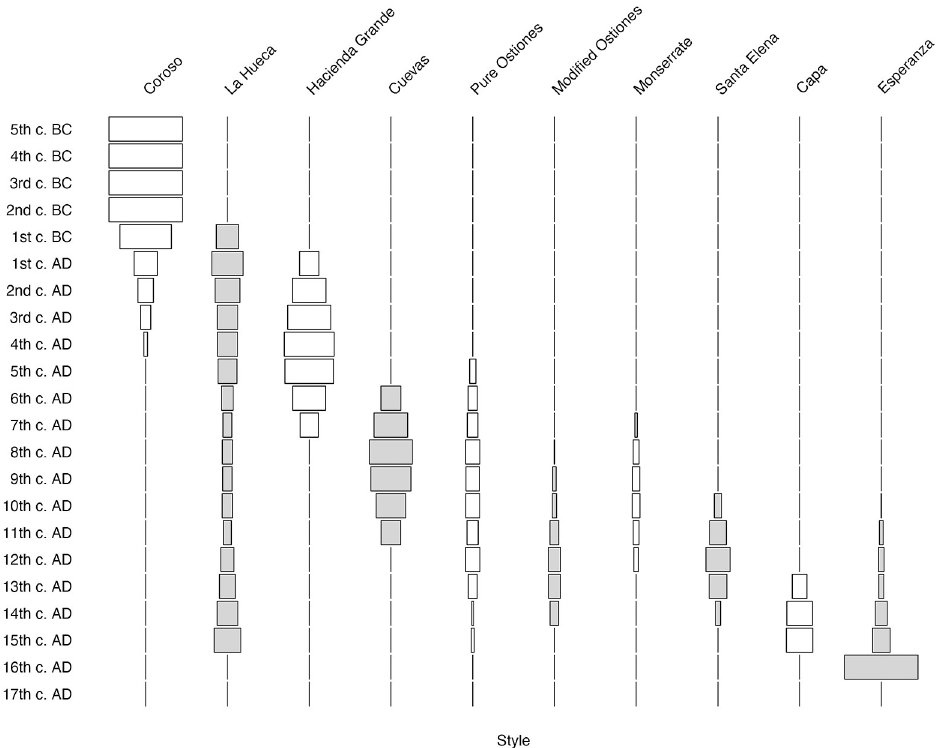
Fig 18. Battleship curves (percent of dates by style and century) of modeled and calibrated dates (mcal) for 10 Rousean styles. Note that Coroso style’s duration is artificially begun in the 5 th century B.C., as its prolonged duration (over 4000 years) otherwise distorts scale of figure to such a degree as to make it useless. Moreover, 100% of dates prior to 5 th century B.C. belong to Coroso style.